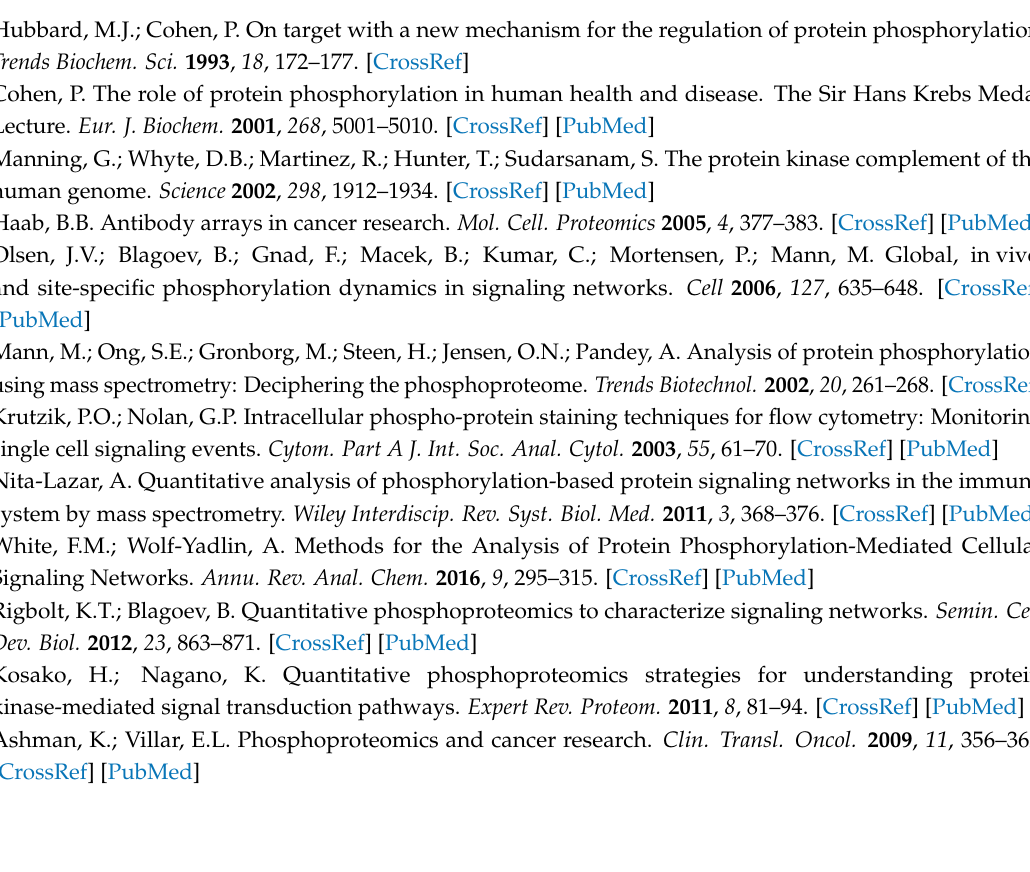
Supplementary Materials: The following are available online. Table S1: Details of retinoblastoma samples used in the study; Table S2: List of hyperphosphorylated peptides identified in retinoblastoma; Table S3: List of hypophosphorylated peptides identified in